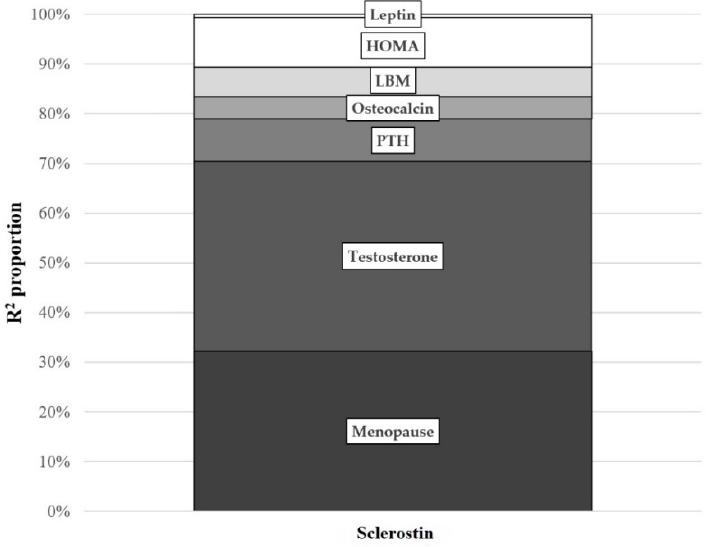
Figure 2. Total variance proportion (R 2 proportion) observed for each variable with the use of an univariate analysis of variance in sclerostin prediction model according to η 2 values.